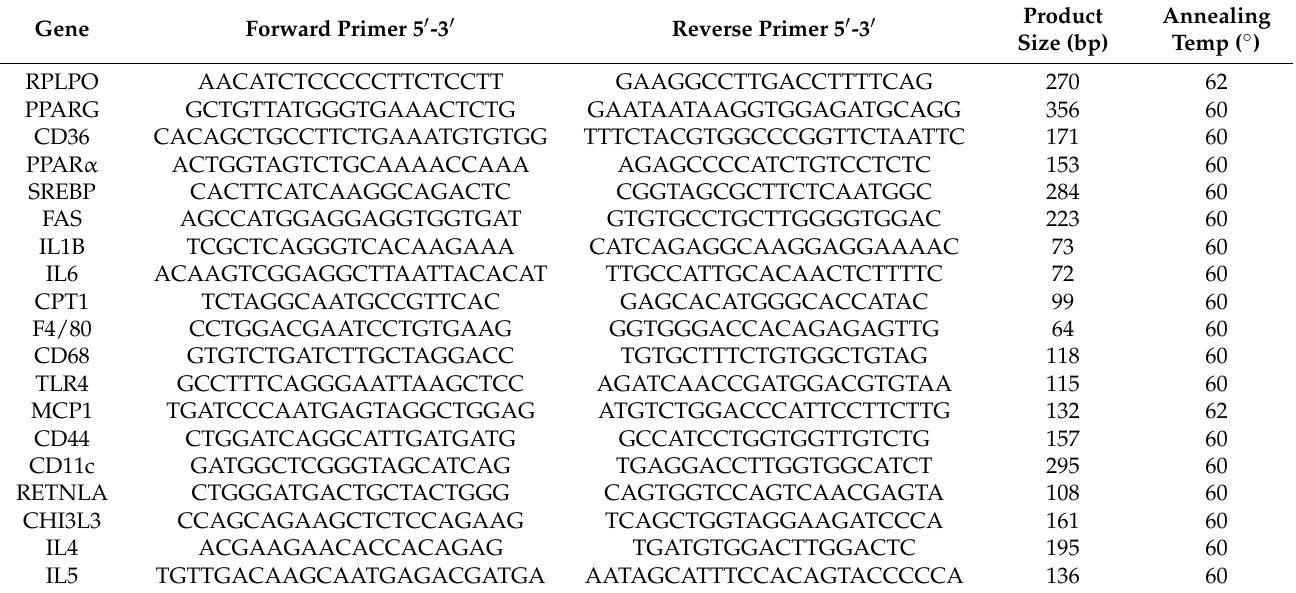
Table 1. Primer sequences for